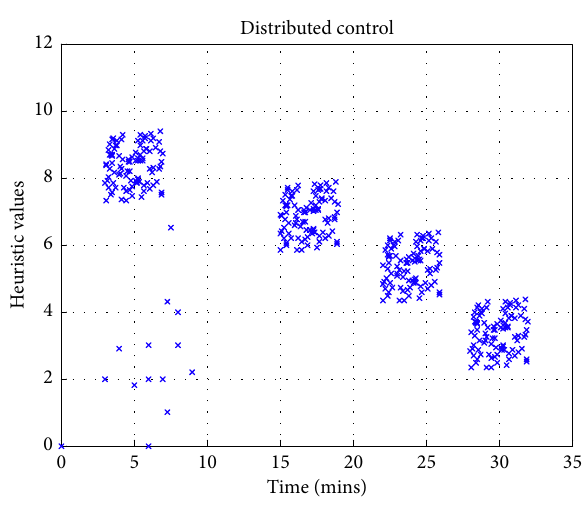
Figure 5: Heuristics being